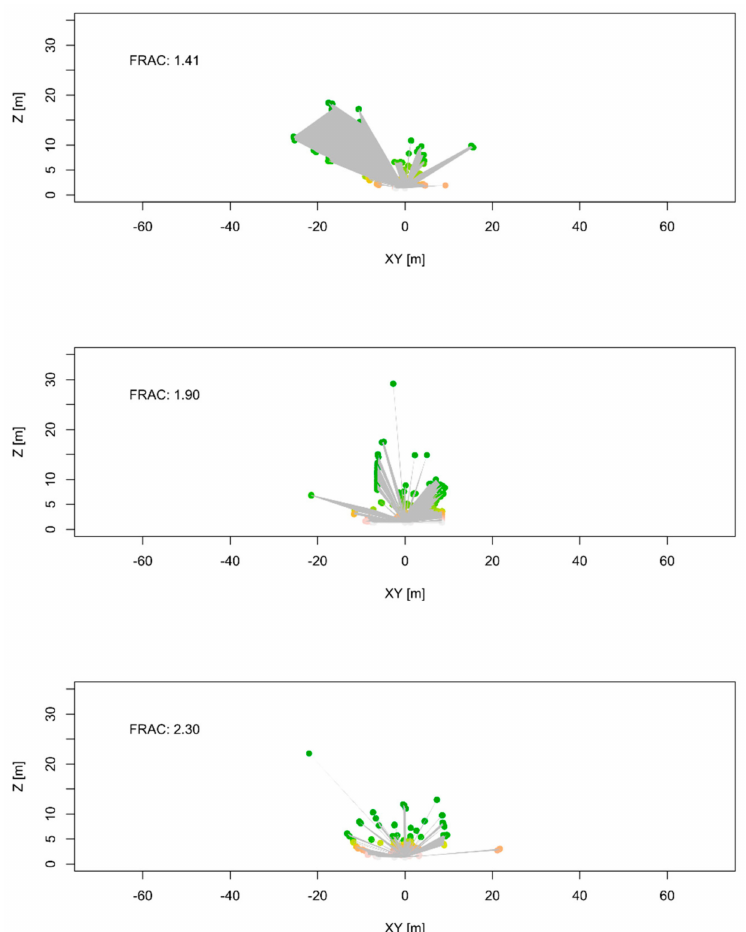
Figure 4. Examples of di ff erent vertical scanlines from a terrestrial laser scanning (TLS) data for stand structural complexity index (SSCI) calculation. Colored points indicate the returns to the scanner; gray area shows the constructed polygon. The upper figure is an example for low, the central figure for medium and the lower figure for high fractional dimension (FRAC)